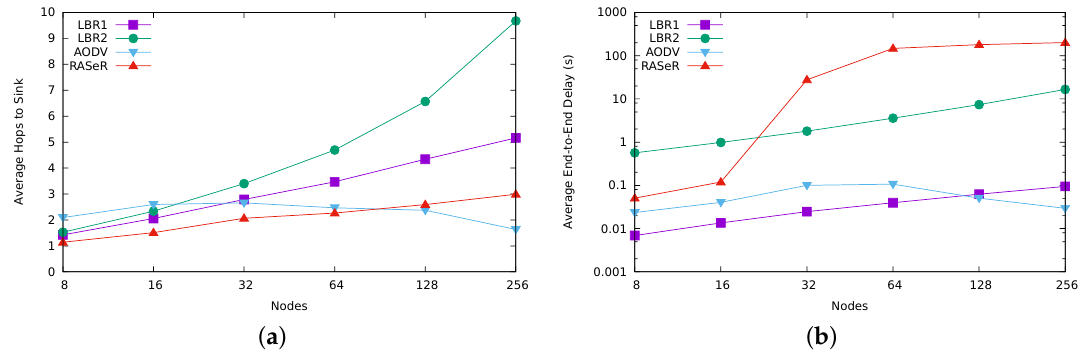
Figure 7. End-to-end delay results about scalability (network size). Results for a maximum velocity of 20 m/s. Note the logarithmic scale on the y axis for Figure 7b. ( a ) hops to reach the sink (average); ( b ) end-to-end delay (average).